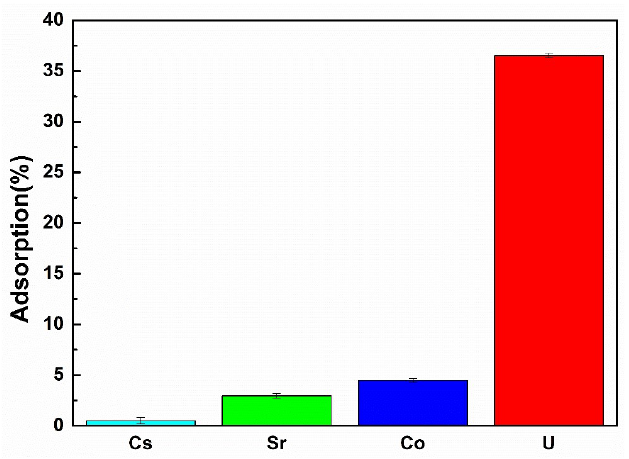
Figure 8. Selective sorption capacities of coexistent ions on TA/GO composites at C initial = 1.0 × 10 −4 M.